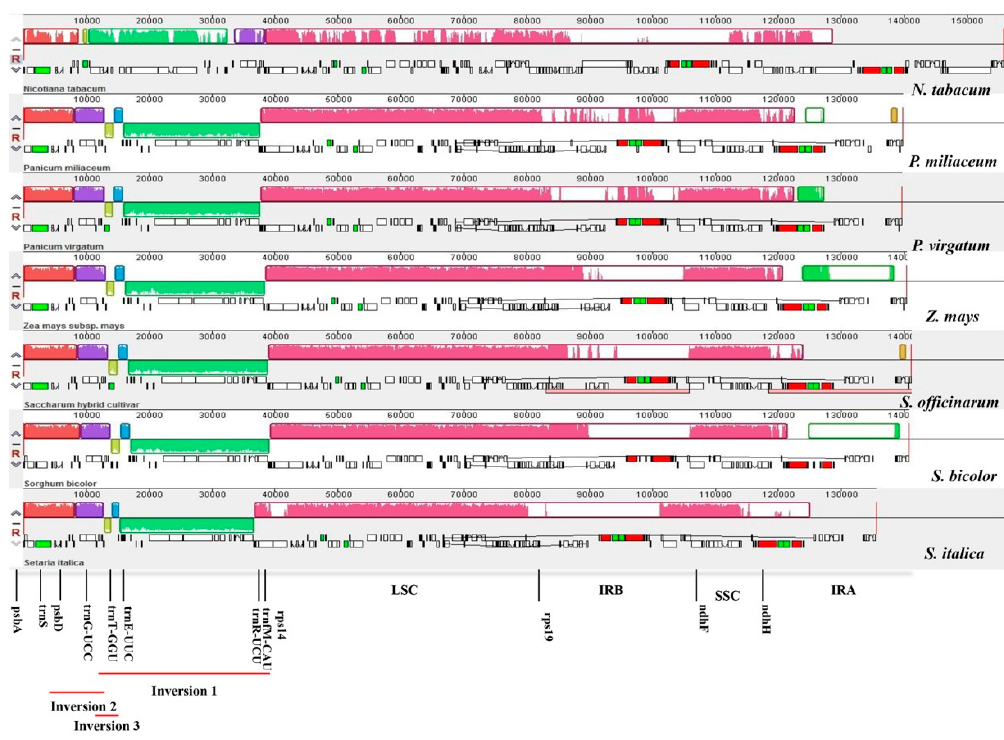
Figure 4. Comparison of the genome structure of six Panicoideae chloroplast genomes, with N. tabacum as the reference. The boxes above the line represent DNA sequences in a clockwise direction, and those below the line represent DNA sequences in the counterclockwise direction.